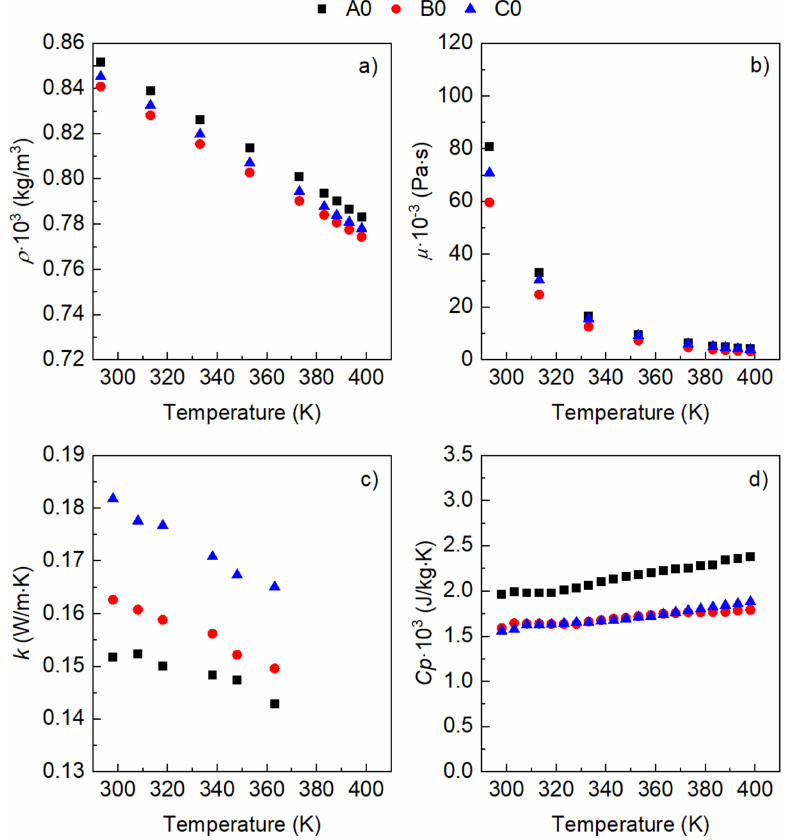
Figure 2. Thermophysical properties of the fresh ATFs (A0, B0, C0): ( a ) density ( ρ ), ( b ) dynamic viscosity ( µ ), ( c ) thermal conductivity ( k ), and ( d ) heat capacity ( C p